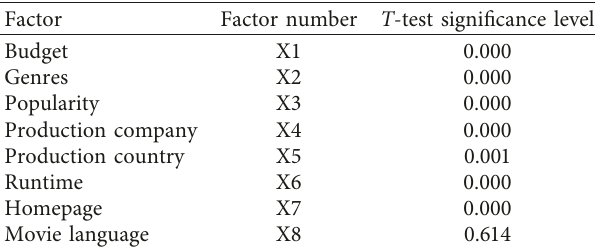
Table 1: Significance test table of box office influencing factors.